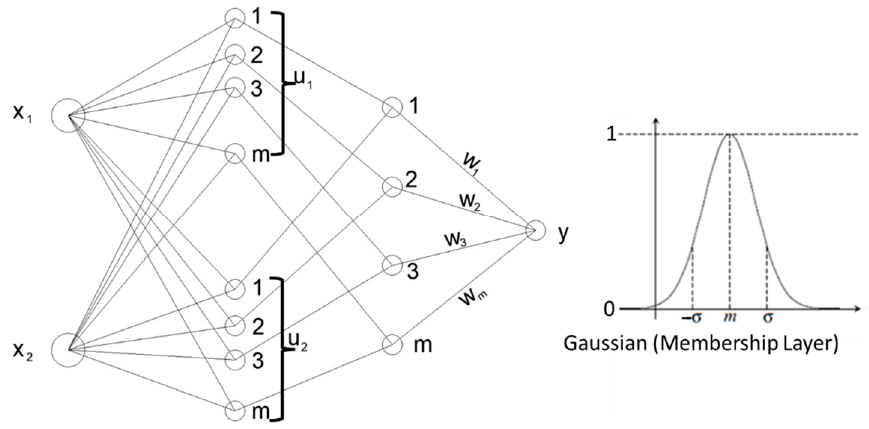
Figure 3. The architecture of the four ‐ layer fuzzy neural network.